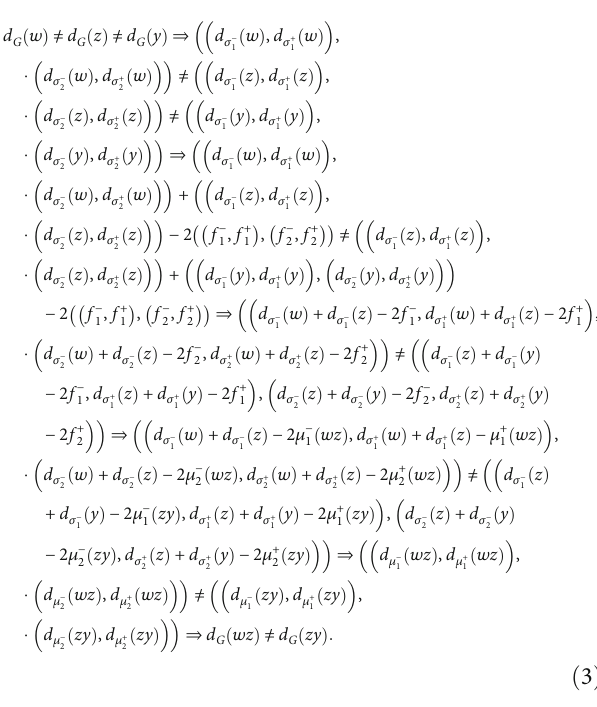
From Figure 5, d ð v Þ = d ð w Þ = ðð 0 : 2,0 : 6 Þ , ð 0 : 4,0 : 8 ÞÞ . d G G